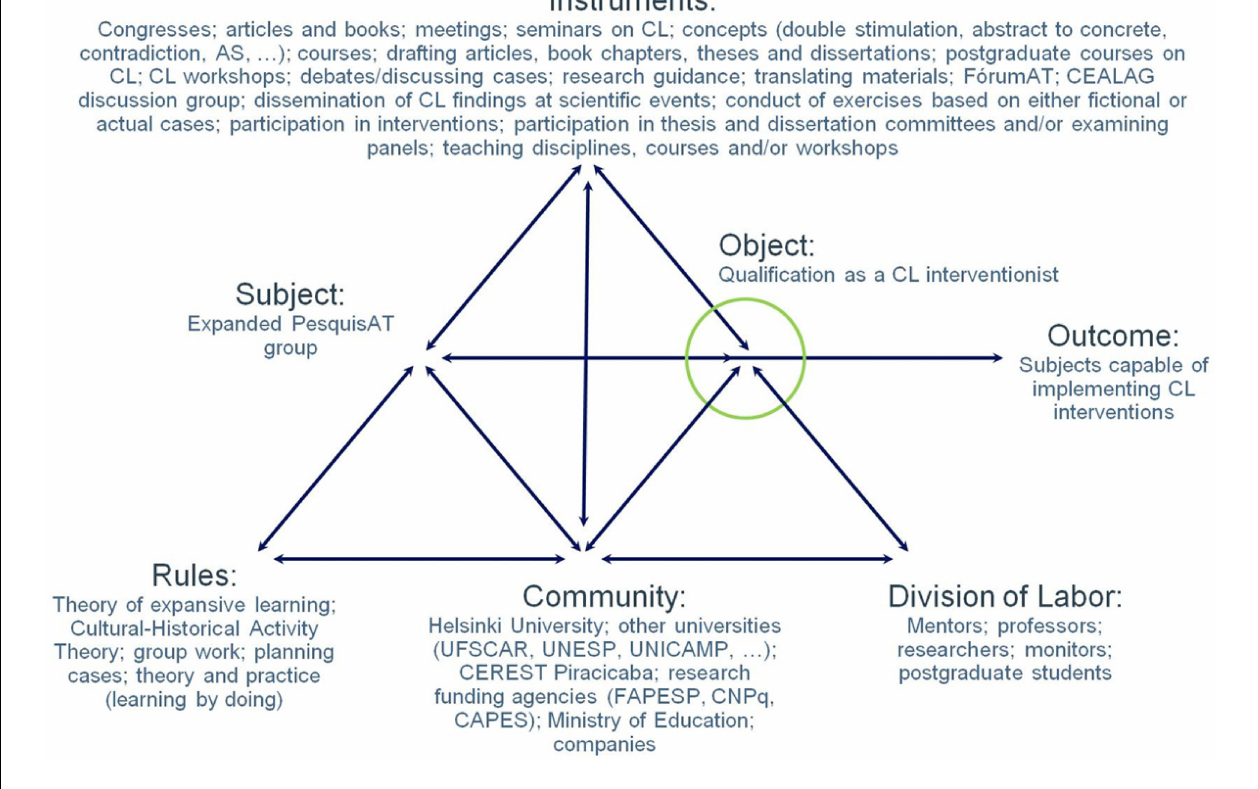
FIGURE 4 | Post-change Laboratory learning platform of the PesquisAT group (2020).